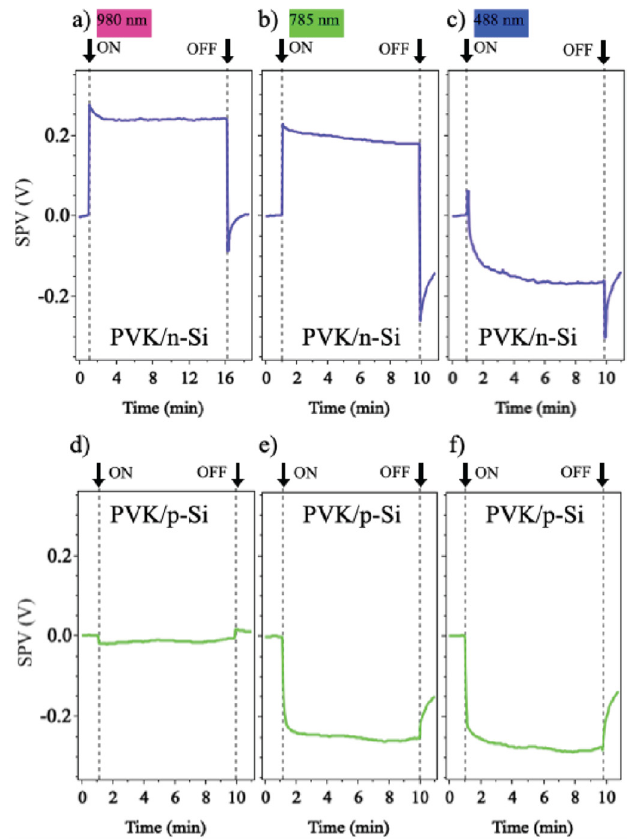
Fig. 3. The SPV measurements of the PVK/c-Si samples using different illumination wavelengths. Results for PVK/n-Si are shown on a-c and for PVK/p-Si on d-f. The dashed grey lines indicates when the light was turned on and